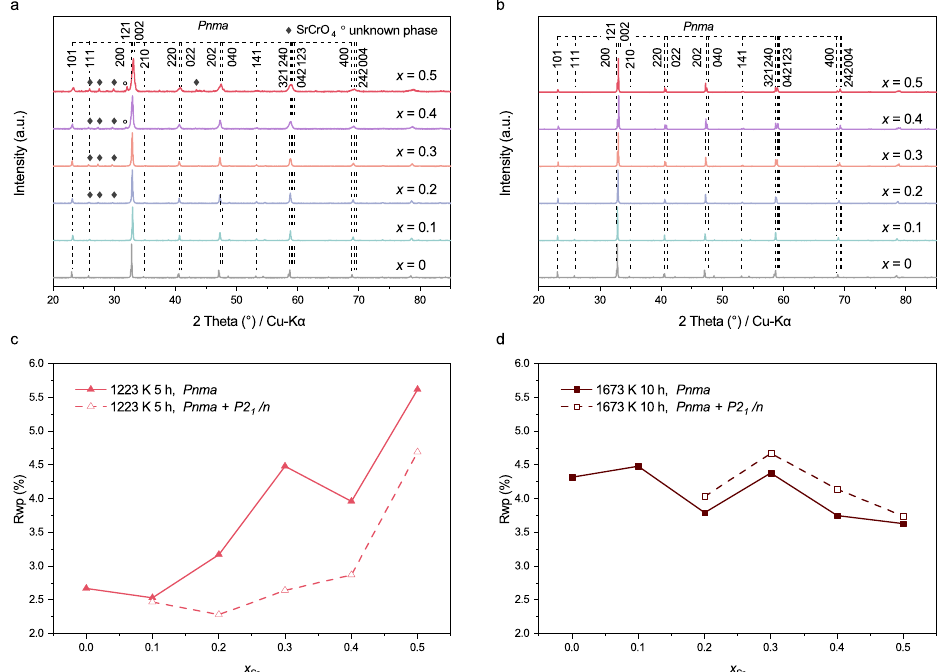
Figure 1. Room-temperature XRD patterns of Pr 1– x Sr x (Cr,Mn,Fe,Co,Ni)O 3– δ ( x = 0–0.5) powders calcined at ( a ) 1223K and ( b ) 1673K. Reflections of the main phase were indexed according to the results of Rietveld refinement using PrCrO 3 (ICSD 251098) as the starting structure. The diamond symbols denote Bragg positions of SrCrO 4 (ICSD 40922). Results of Rietveld refinements of corre- sponding powders calcined at ( c ) 1223K and ( d ) 1673K. The solid lines present the Rwp factors of refinements using PrCrO 3 ( Pnma , ICSD 251098) as the starting structure, while the dashed lines draw the Rwp factors of refinements using PrCrO 3 ( Pnma , ICSD 251098) and SrCrO 4 ( P 2 1 / n , ICSD